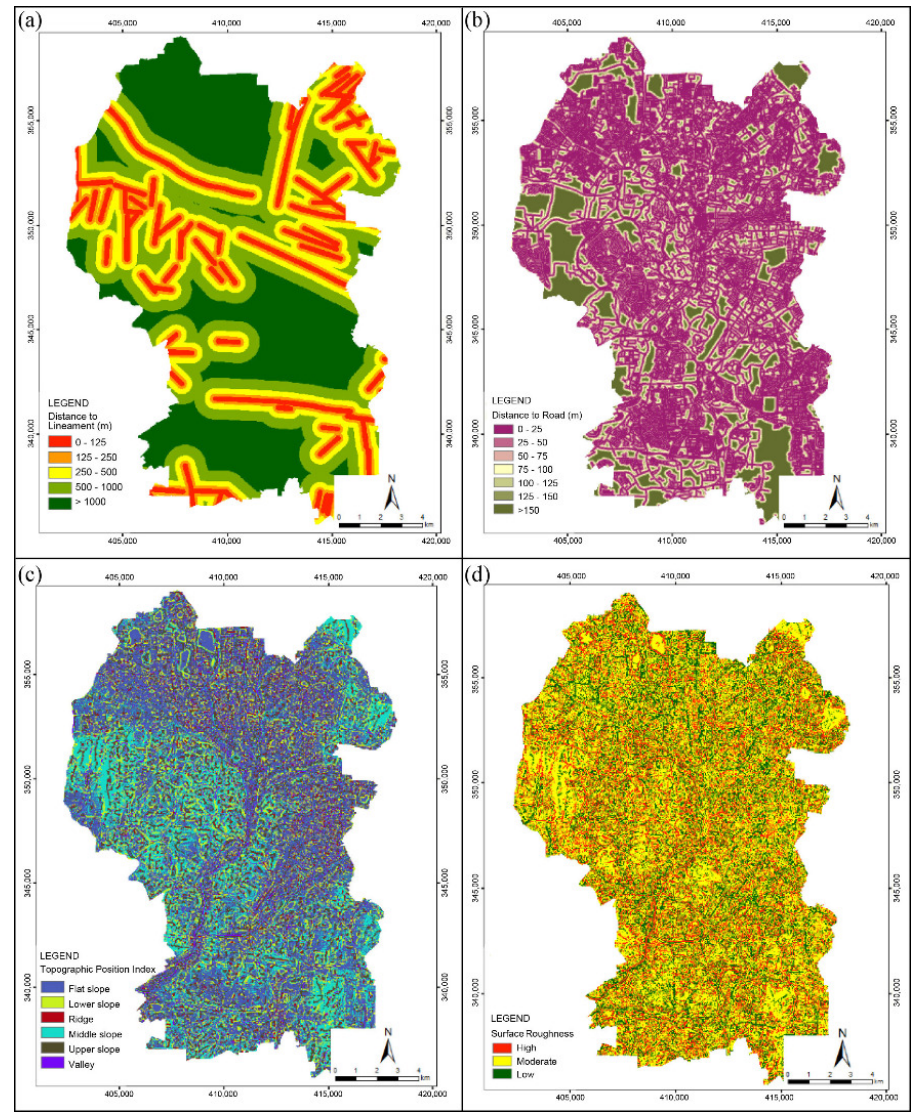
Figure 3. Map of the landslide conditioning factors on distance to lineaments ( a ), distance to roads ( b ), topographic position index ( c ), and surface roughness ( d